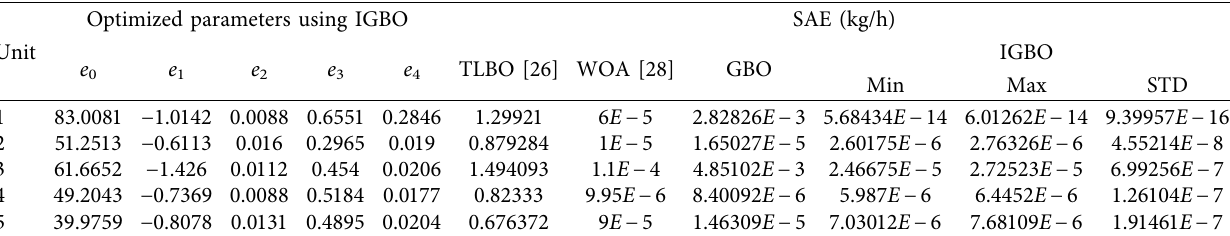
Table 12: Optimized parameters and SAE of model 7.